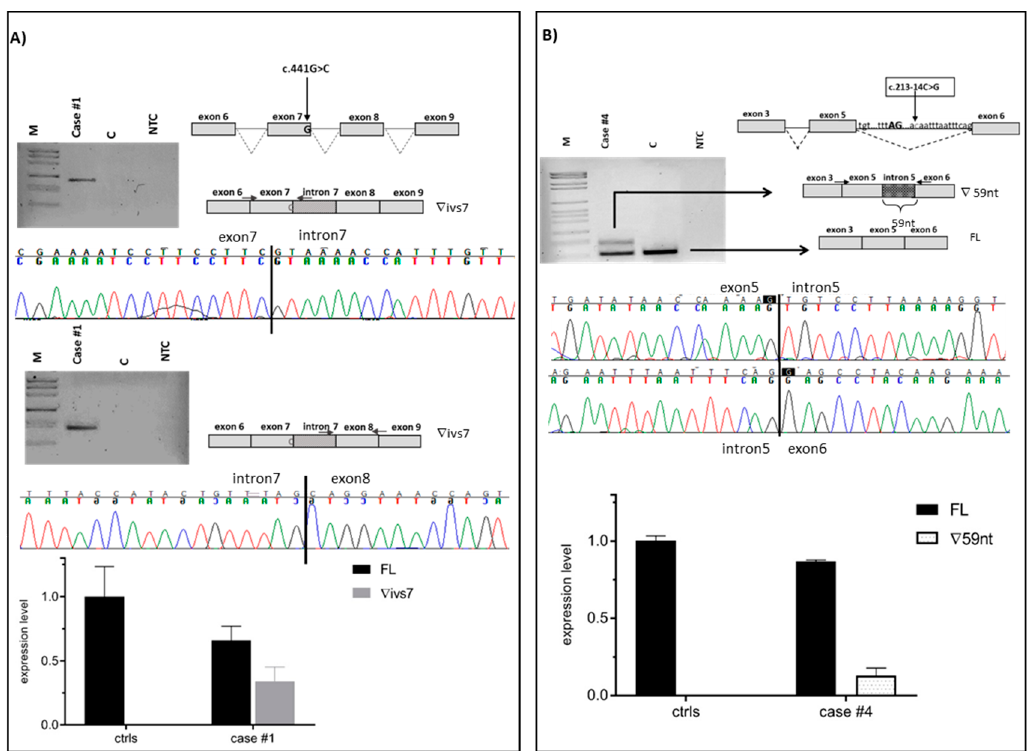
Figure 1. mRNA analysis of spliceogenic BRCA1 variants. Amplified products were separated on 3% agarose gel and independently sequenced. Gel images, graphical representation, and exon–intron junction sequences of full-length (FL) and aberrant transcripts are shown in upper panels. Variants and RT-PCR primers locations are indicated by the arrows. qPCR results are shown as histograms displaying the relative expression of the full-length and aberrant transcript in the patient’s and controls’ samples (lower panels). ( A ) c.441G>C, causing the retention of intron 7 ( ∇ ivs7). The aberrant transcript accounts for 0.34 ( ± 0.11) of overall gene expression in the variant carrier (case #1) and is undetectable in controls. ( B ) c.213-14G>C, causing the retention of 59 nt at the 3 ′ -end of intron 5 ( ∇ 59nt). The aberrant transcript accounts for 0.13 (±0.05) of overall gene expression in the variant carrier (case #4) and is undetectable in controls. M, molecular weight marker (0.15–2.1 Kbp, Roche); C, healthy control sample; NTC, no template control.